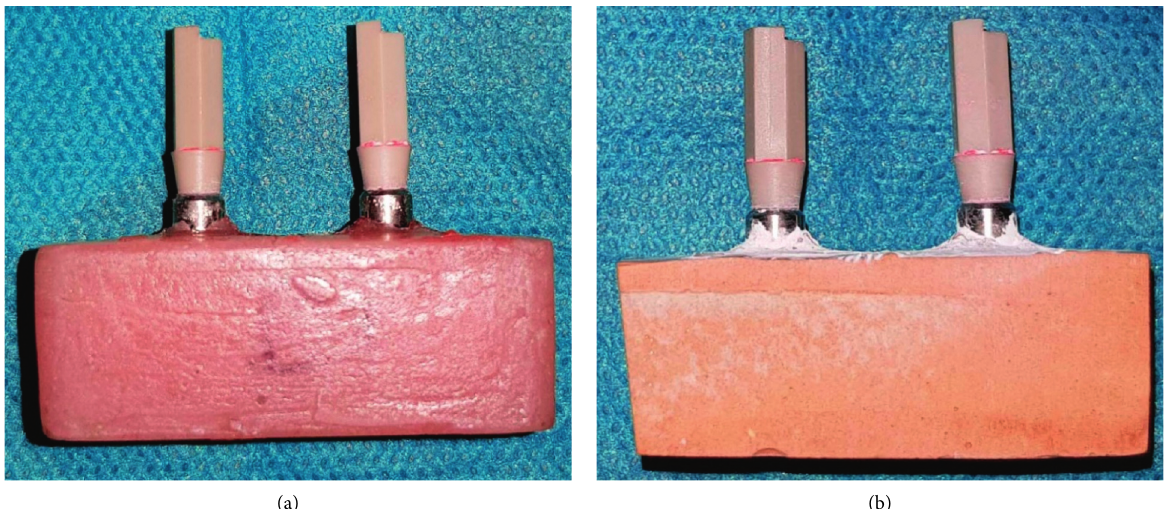
Figure 4: (a) The fabricated model. (b) The prepared